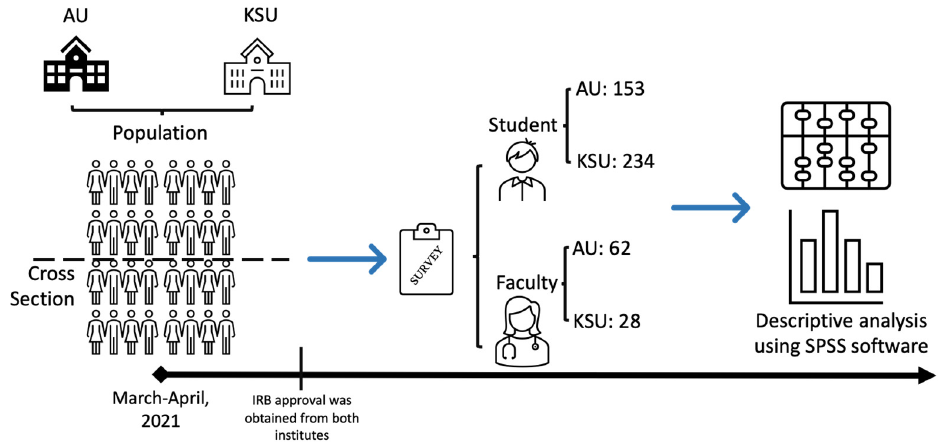
Figure 1. Flow diagram depicting the methodology we followed in this